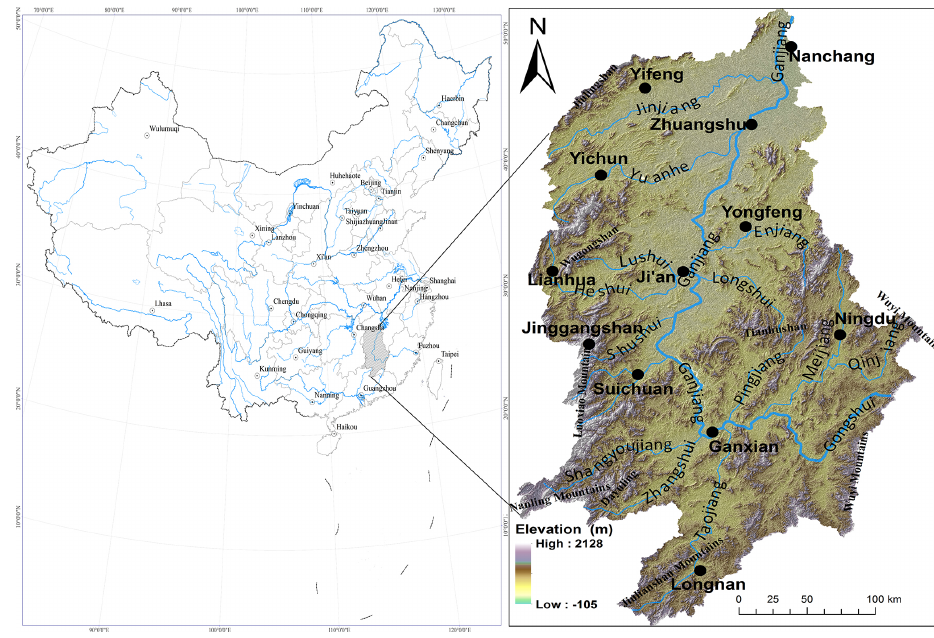
Figure 1. Study area and location of meteorological